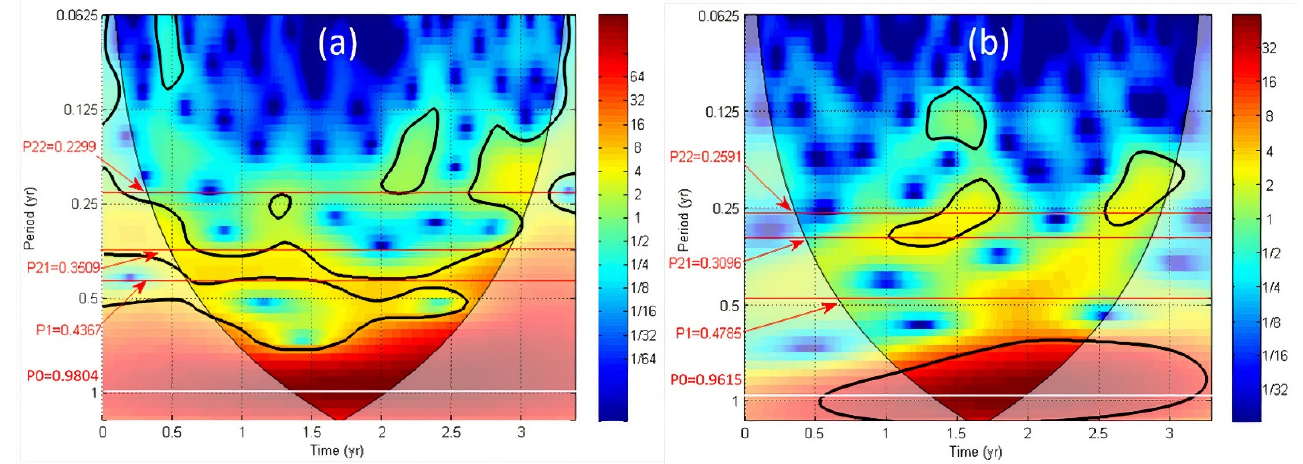
Figure 7. The continuous wavelet transform (CWT) during 3.3 years (September 2016–December 2020) are shown for two vertical displacements: ( a ) EXT2 and ( b ) VERT-ASC-DES at WP. The thick contour designates the 5% significant level against red noise (see Materials and Methods section). The Cone of Influence (COI) where edge effects might distort the picture is shown as a lighter shadow.